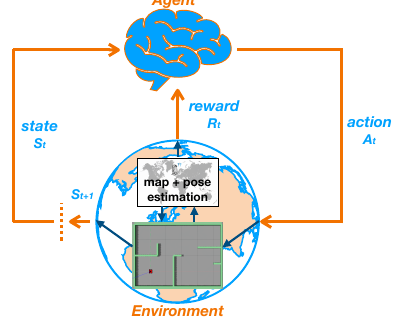
Figure 1. Proposed framework combining reinforcement learning and SLAM where the reconstructed 2D map and the pose estimation of the SLAM algorithm contributes to both state estimation and reward shaping process. As a result, the agent can choose the best action to steer the robot and to support the continuation of the active SLAM